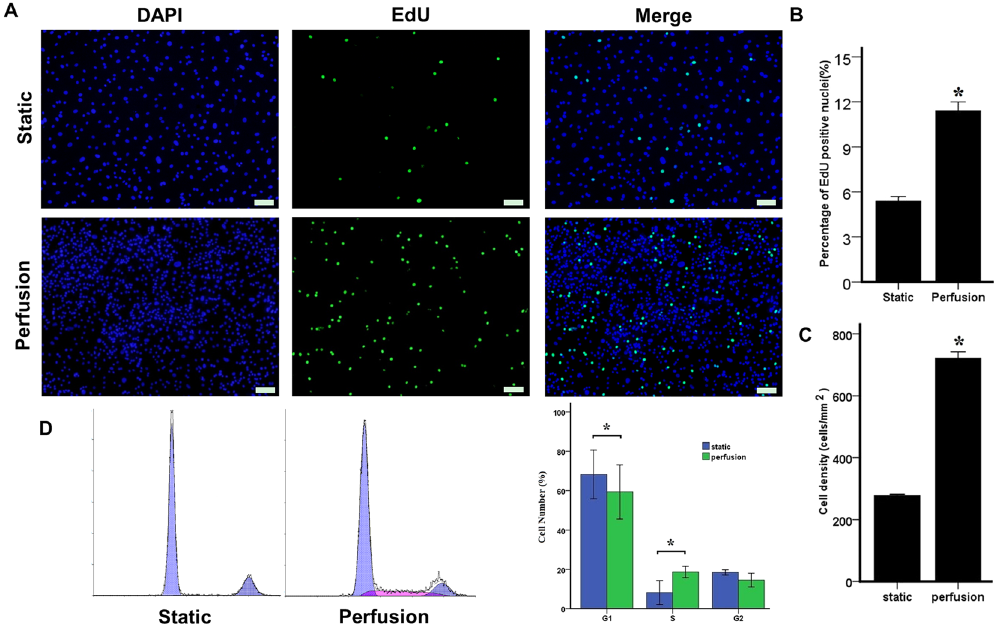
Figure 2. Effects of the perfusion system on the growth ability of CECs. ( A ) EdU assay of CECs in the static and perfusion systems. Scale bar: 100 µ m. ( B ) The proliferation of CECs was evaluated based on the ratio of EdU- positive cells to total cells. ( C ) Quantification of the cell density in the static and perfusion systems. ( D ) Flow cytometry analysis of the cell cycle in the static and perfusion systems. The data are presented as the mean ± SD of three independent experiments. Differences with * P < 0.05 were considered to be statistically